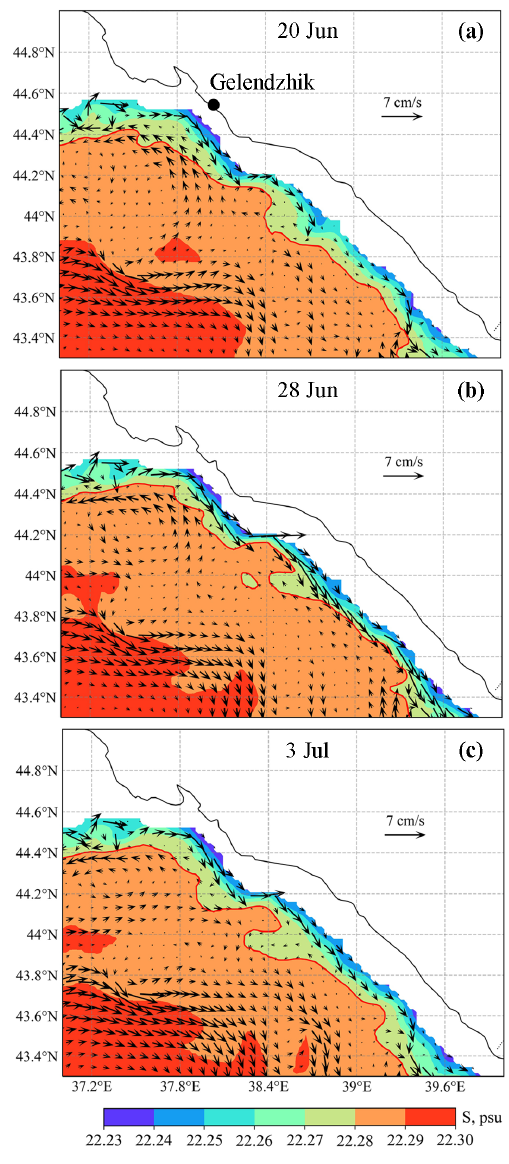
Figure 6. Current velocity and salinity fields at the horizon of 1100 m by the MHI model data on ( a ) 20 June, ( b ) 28 June, and ( c ) 3 July 2011. Red line denotes the 22.28